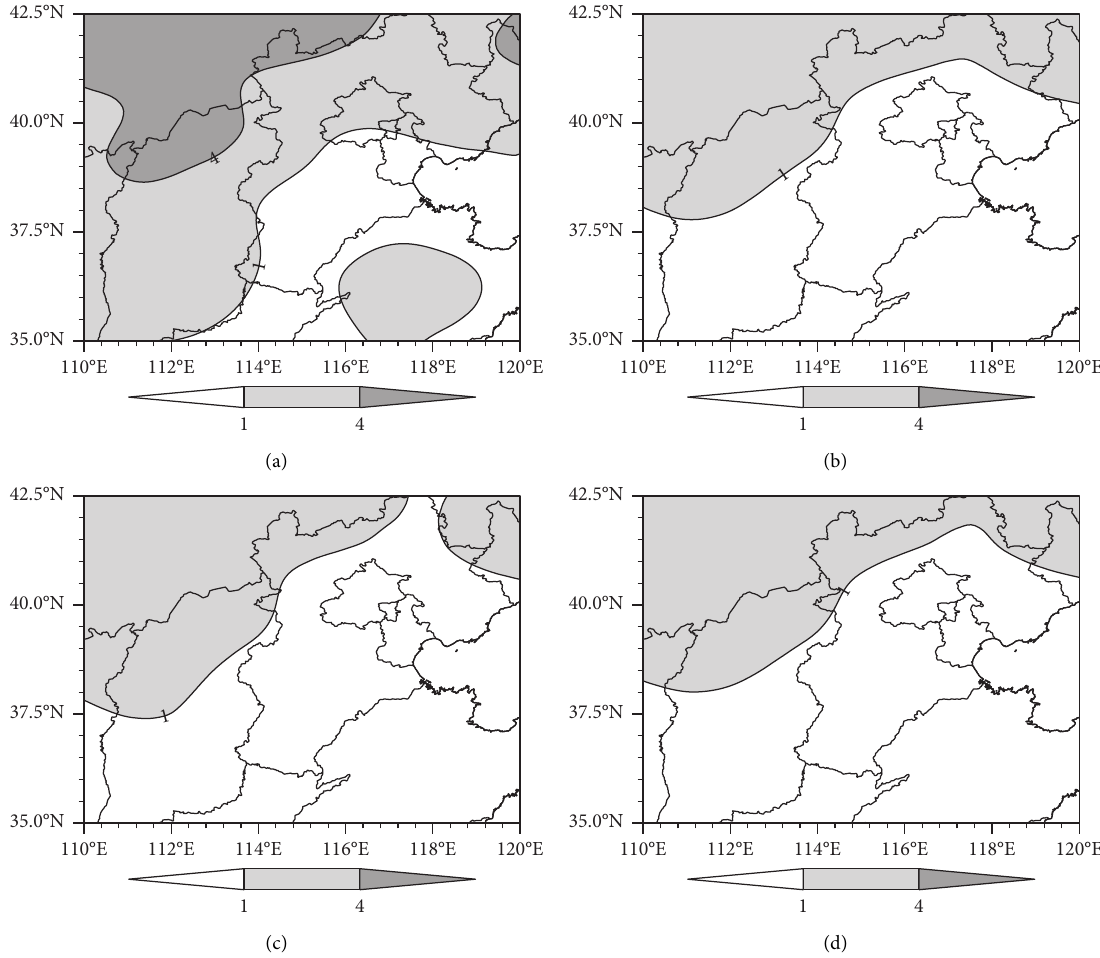
Figure 2: Spatial distribution of the multi-year average frequency of SSECEs in North China in winter (a), December (b), January (c), and February (d). Unit: number of occurrences.